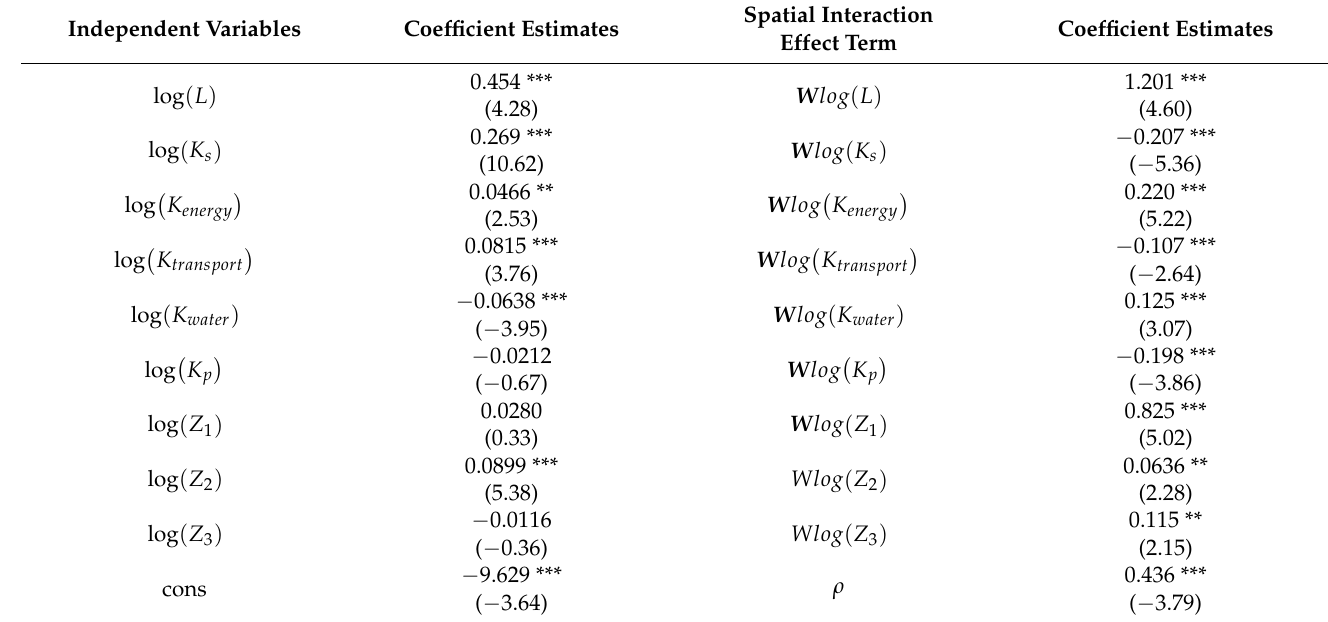
Table 5. Estimation results of the SDM with random